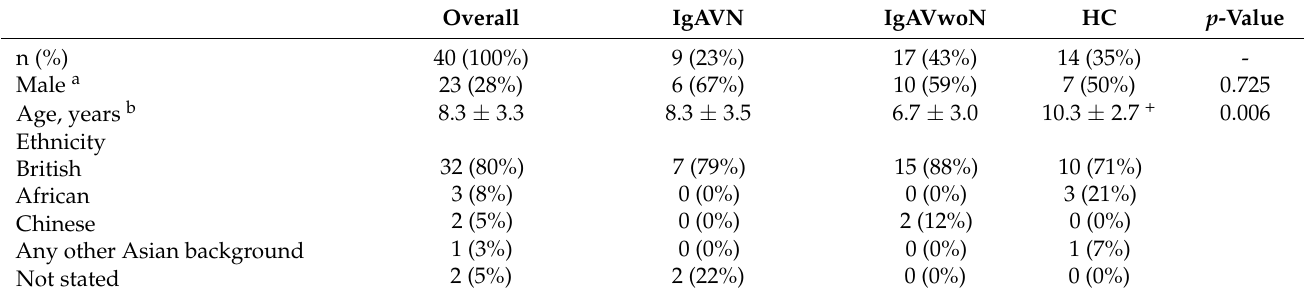
Table 1. Patients characteristics at baseline. a n (%); b mean ± SD. 1 BP readings available for 8 patients of the IgAVwoN group. 2 Serum creatinine was available for 13 patients (IgAVN, n = 8;